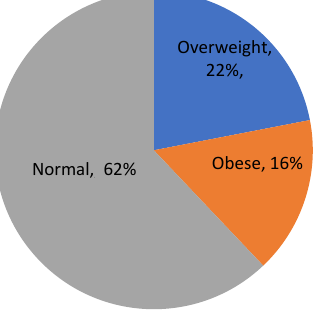
Figure 3. Blood pressure distribution of studied population based on BMI